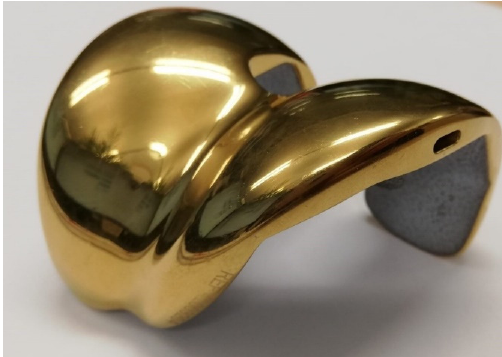
Figure 1. Femoral part of the Advanced Coated System (ACS) total knee prosthesis with the easily identifiable golden color of titanium-nitride (TiN).